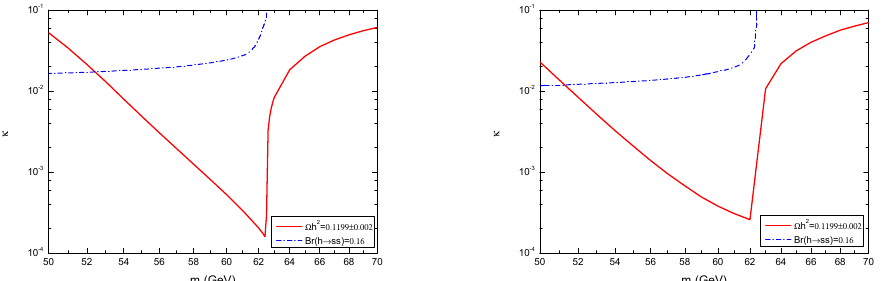
Figure 2 . Constraint from SM Higgs invisible decay at the LHC in the model A ( left ) and model B ( right ), respectively. The red curve in each plot corresponds to the DM relic